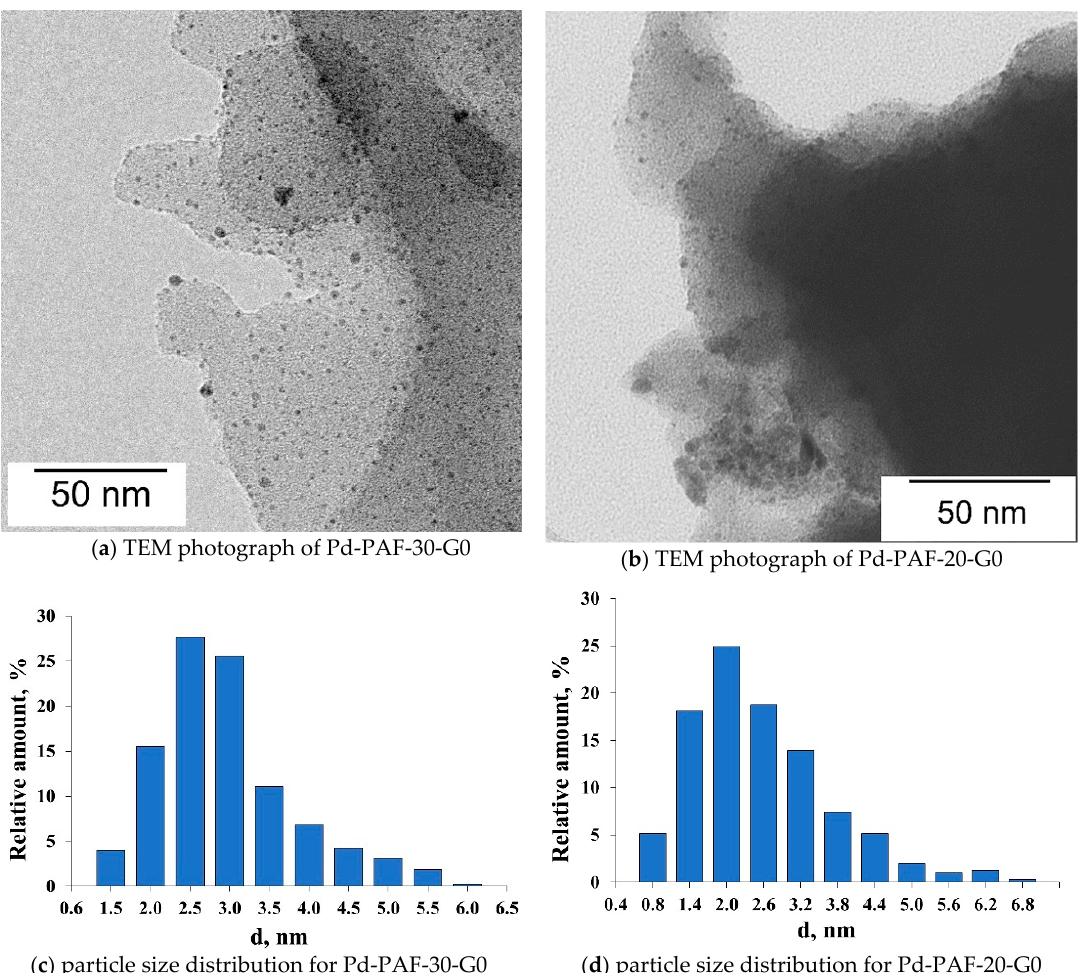
Figure 3. Transmission electron microscopy microphotographs and particle size distribution for Pd–PAF-20-G0 and Pd-PAF-30-G0.